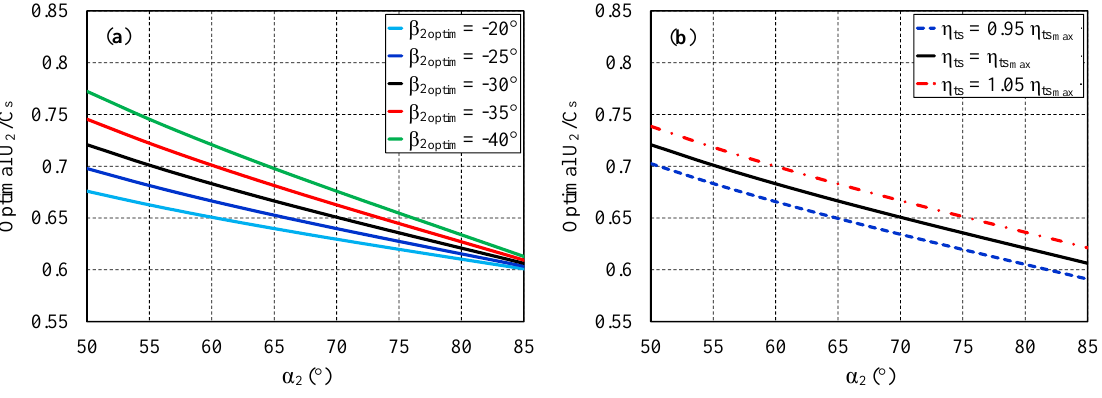
Figure 5. ( a ) Sensitivities to the optimal relative angle β 2 the maximal efficiency (plotted for β 2